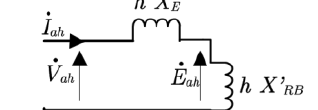
Fig. 1. Induction machine representative electrical circuit.